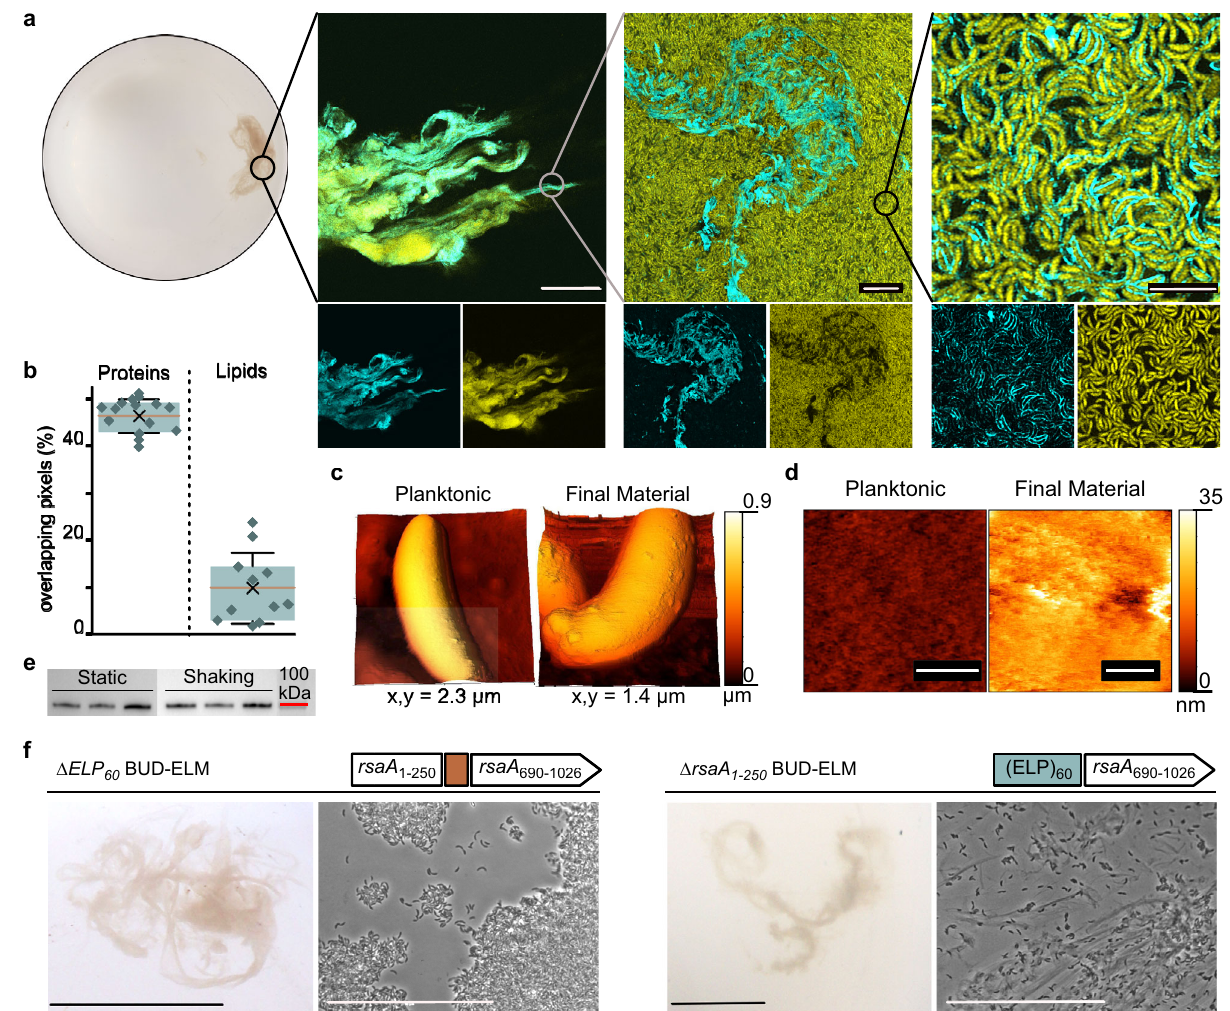
Fig. 2 | BUD-ELMs contain a de novo protein matrix and display a hierarchical structure. a Confocal microscopy of ELMs stained with SpyCatcher-GFP at increasing magni fi cations, showing a hierarchical structure. The bottom images showindividual fl uorescentchannels:GFP(matrix)ontheleftandmKate2(cells)on the right. Scale bars are, from left to right, 100, 10, and 5 µ m, respectively. b Percentage of overlapping pixels between cell-free and stained regions, con- fi rming the absence of lipids in the BUD protein matrix. Error bars are centered on the mean value (cross) and represent the standarddeviation; the red line indicates themedianvalue;theboxesshowtheinterquartilerange(25 – 75%).Theanalysishas been performed on 16 images for the protein and 11 for the lipid staining, each obtained from three independent samples. Source data are provided as a Source Data fi le. c AFM images of single cells at early (left) and late (right) stages of BUD-